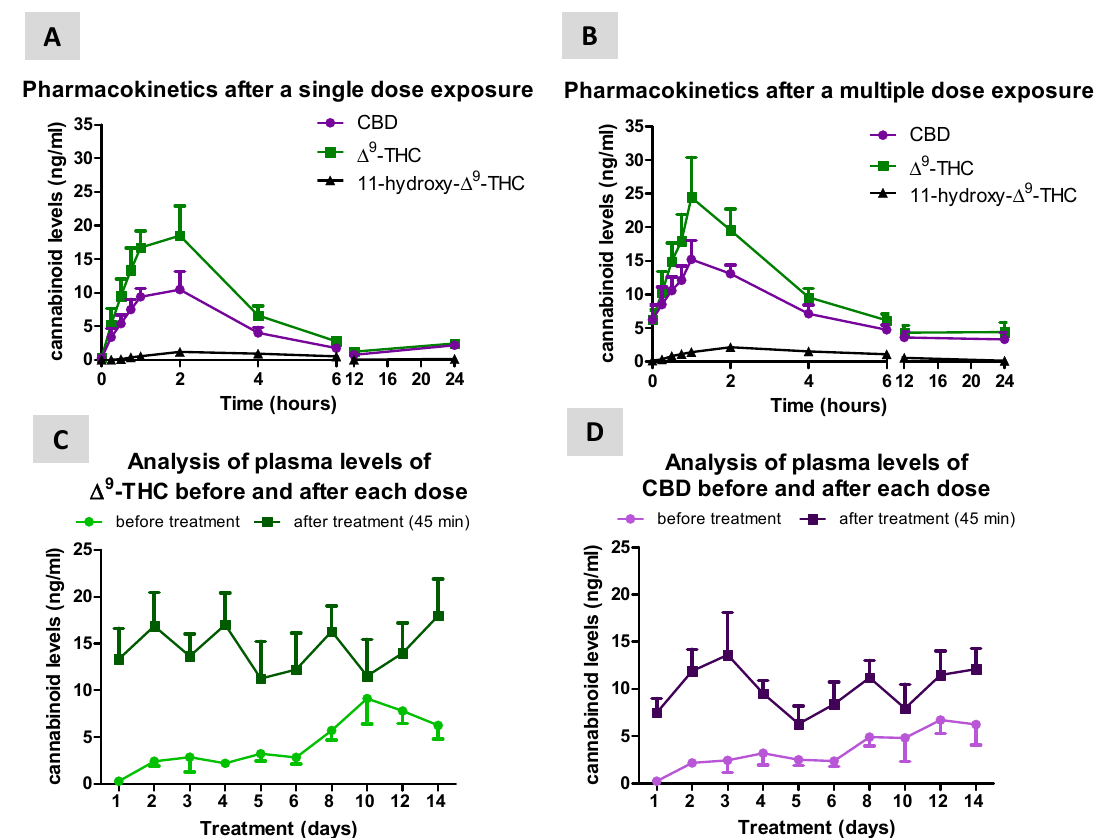
Figure 1. Plasma levels of CBD, Δ 9 -THC and its metabolite 11-hydroxy- Δ 9 -THC measured in naïve dogs at different times after a single dose ( A ) or multiple dose ( B ; 14 days) treatment with Sativex delivered by sublingual administration (3 consecutive sprays equivalent to 8.1 mg of Δ 9 -THC and 7.5 mg of CBD). Panels ( C ) and ( D ) represent the comparison of Δ 9 -THC and CBD levels before (pre-dose values) and after treatment (45 min; post-dose values) in the single and multiple dose conditions. Values are means ± SEM of 6 animals per group.